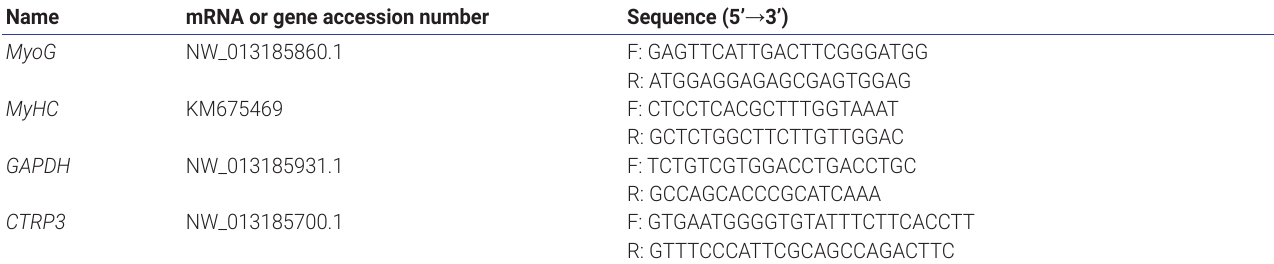
Table 1. Primers for real-time polymerase chain reaction